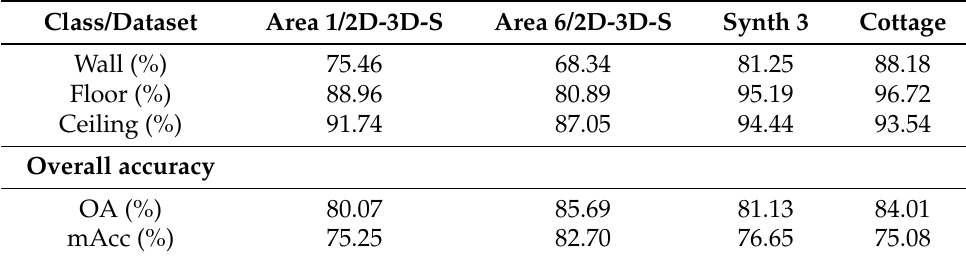
Table 3. Accuracy of semantic